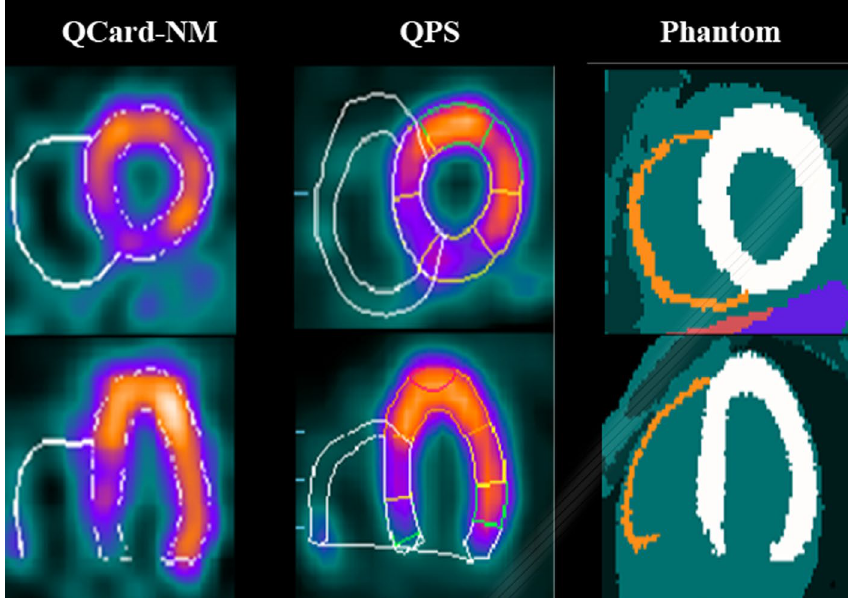
Fig. 9 Example of simulated data with segmentation results of the QCard-NM and QPS algorithms, and the phantom image. Short axis (first row), long axis (second